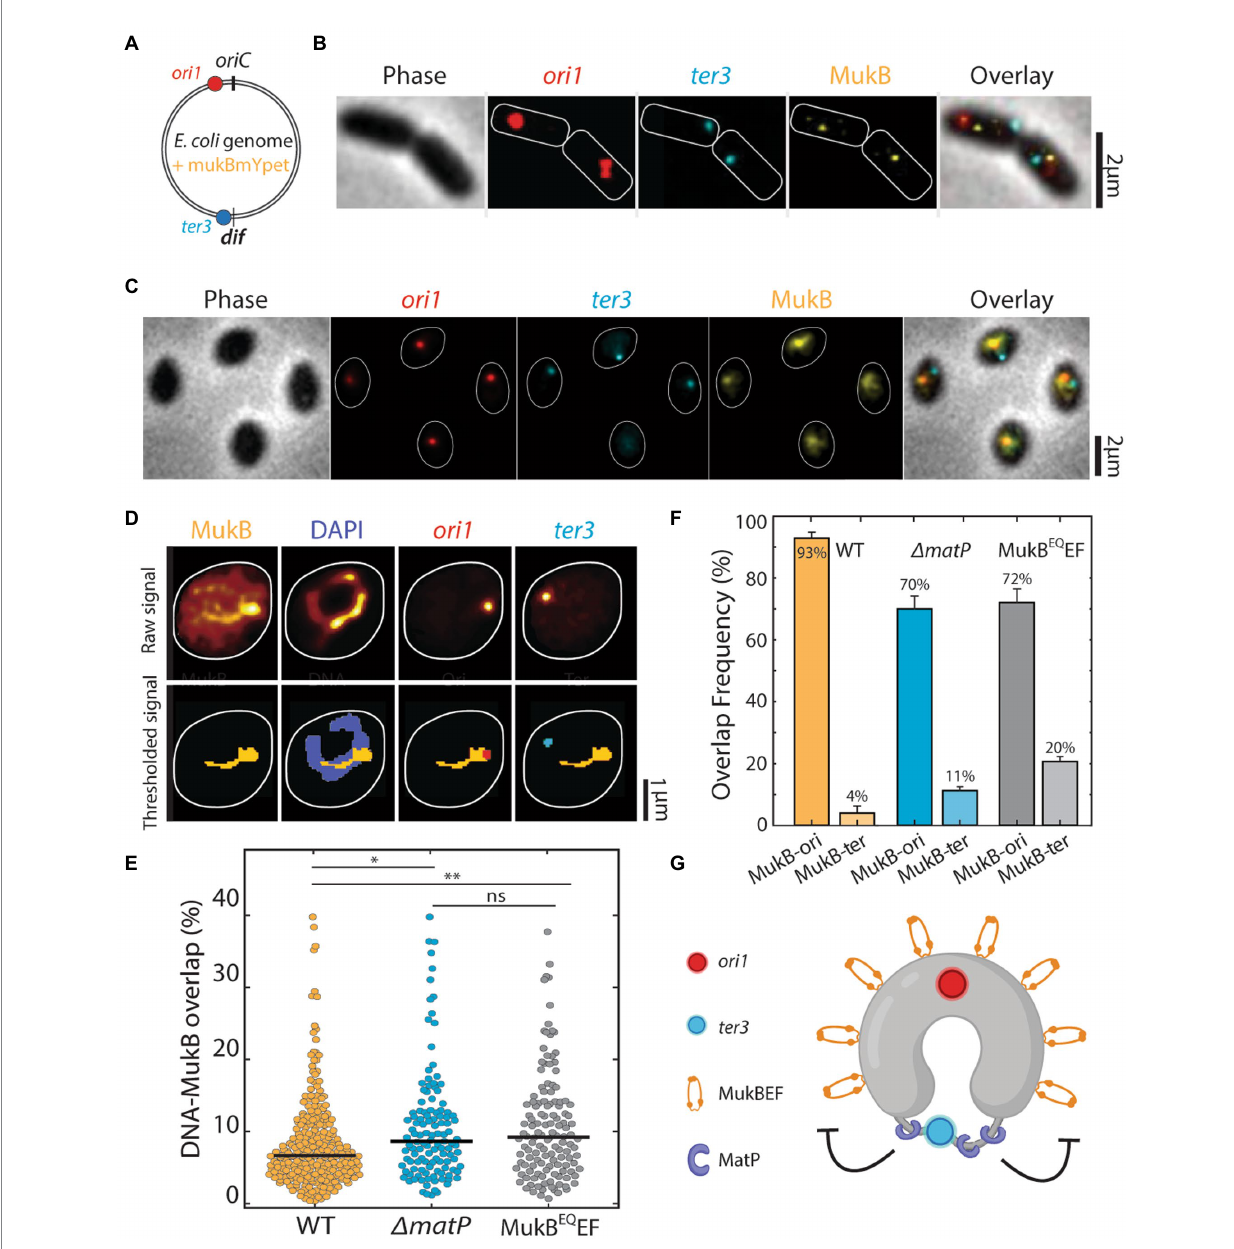
FIGURE 1 Quantitative localization of MukB complexes along the chromosome. (A) Schematic representation of a circular Escherichia coli genome with FROS arrays at ori1 and ter3 location and MukB-mYpet labeling. (B) Representative image of rod-shaped and (C) widened E. coli cells in phase contrast and the fluorescence channels of ori1 , ter3 and MukB. Cell outline is indicated in white. (D) Typical example of the thresholding process to calculate fluorescence signal overlap. (E) Percentage of MukB intensity that overlaps with the DNA mask for wildtype ( N = 260 cells), Δ matP ( N = 121 cells), and MukB EQ EF mutants ( N = 131 cells). (F) Signal overlap between MukB and ori1 and MukB and ter3 foci in wildtype ( N = 260 cells), Δ matP cells ( N = 121 cells) and MukB EQ EF cells ( N = 131 cells). Error bars report on the standard deviation. (G) Schematic representation of MukBEF positioning along the circular E. coli chromosome and its regulation by MatP. Statistical significance was determined by performing a single factor ANOVA test. The following conventions are used: ns: 0.05 < p , *: 0.01 < p < 0.05, **: 0.001 < p < 0.01. We report a significant difference in results if p <